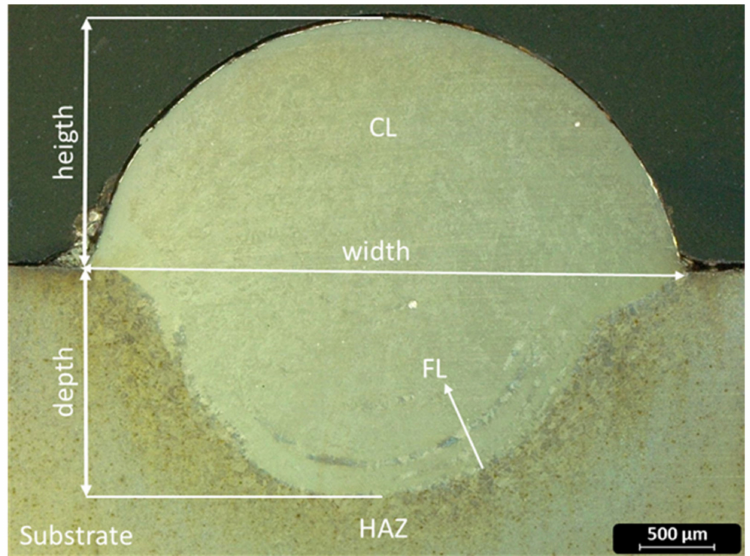
Figure 3. Optical microscopy image showing the morphology of a single-track clad produced by the DLD technique depositing Metco 42C powder on a 42CrMo4 steel substrate. CL—Cladding Layer; FL—Fusion Line; HAZ—Heat-affected